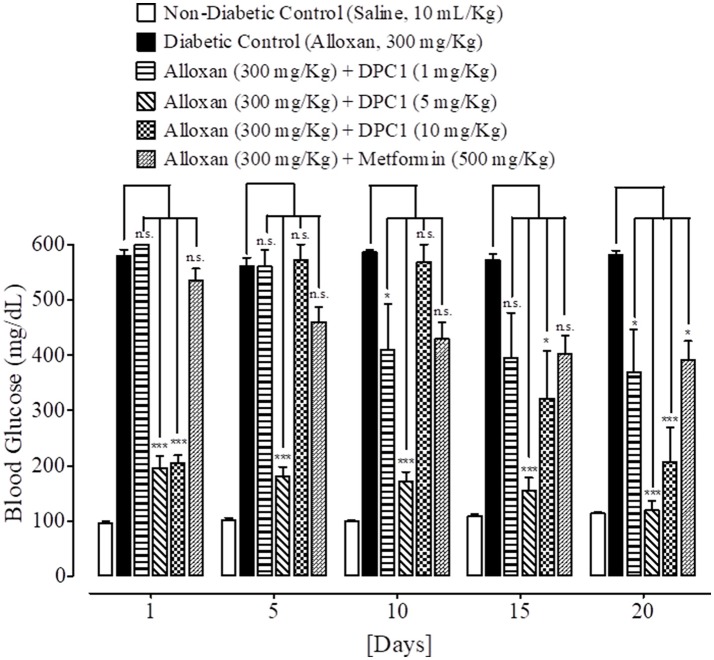
Bar-graph representing blood glucose levels at different treatment days of saline treated group (non-diabetic control), alloxan treated group (diabetic control), inhibitory effect of 1-(4-chlorobenzoyl)-3-(4-ferrocenylphenyl) urea (DPC1) at different doses (1–10 mg/Kg) and metformin treated group against alloxan-induced hyperglycemia in mice. Data presented as mean ± SEM. Statistical analysis used one-way ANOVA, followed by post-hoc Tukey's test. *P < 0.05, ***P < 0.001 comparison of the blood glucose levels of DPC1 and metformin treated groups vs. diabetic control group. n.s., non-significant. The sample size in each group comprised of five mice (n = 5).